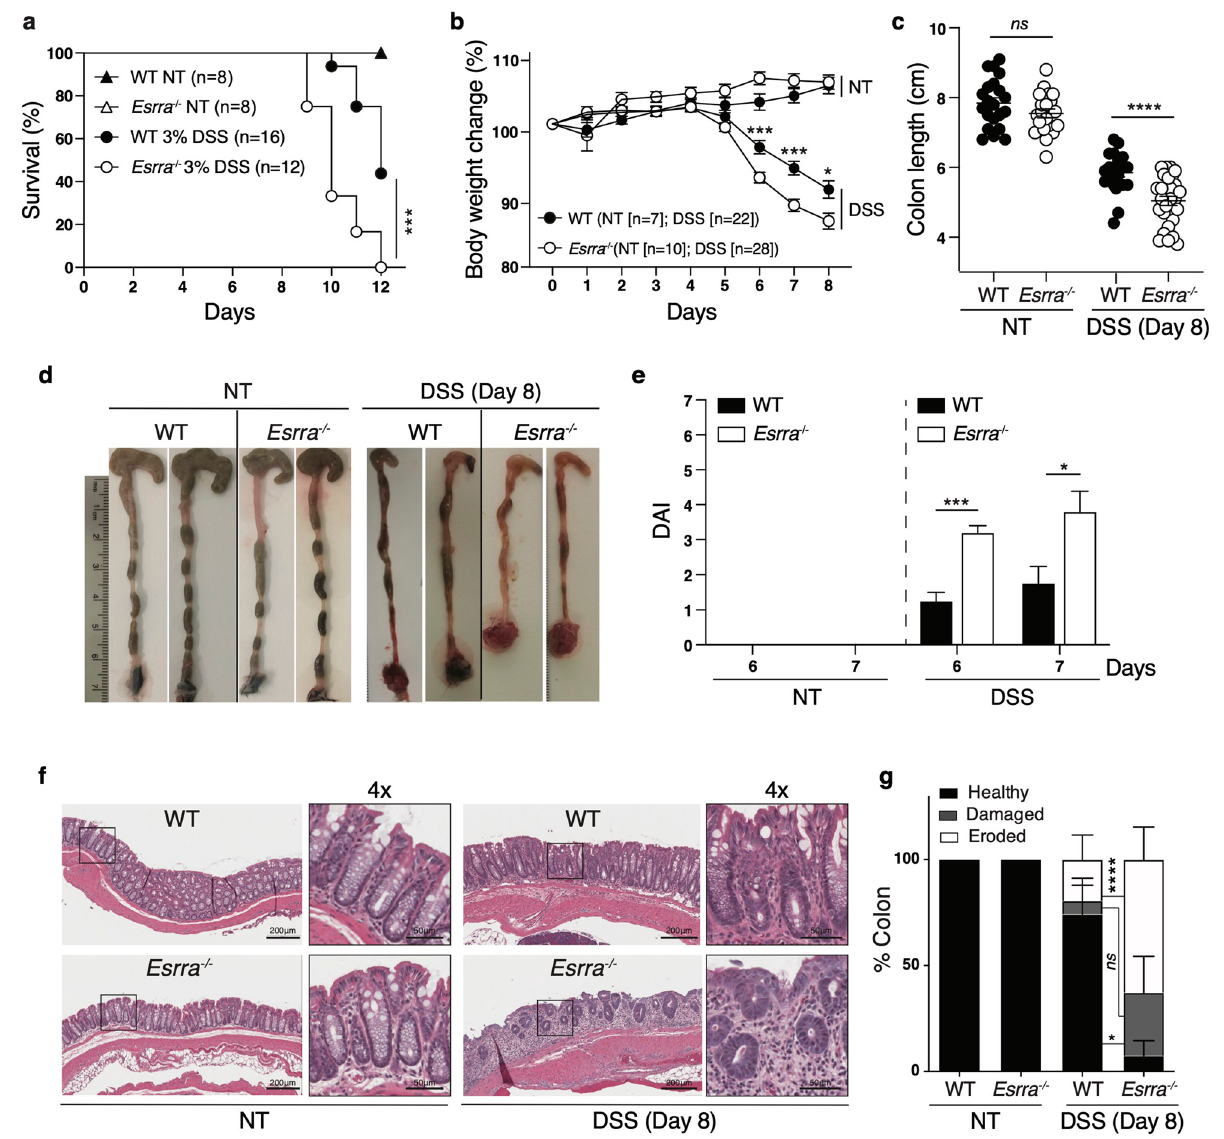
Figure 1. Esrra −/− mice exhibited heightened susceptibility to experimental colitis. ( a ) Survival of untreated (NT) WT (n = 8) and Esrra −/− (n = 8) mice and WT (n = 16) and Esrra −/− (n = 12) mice after 3% DSS treatment. Statistical significance was performed using log-rank (Mantel-Cox) test, ***p < 0.001. ( b ) Body weight loss (%) of untreated (NT) WT (n = 7) and Esrra −/− (n = 10) mice and WT (n = 22) and Esrra −/− (n = 28) mice after 3% DSS treatment. Statistical significance was performed using Student’s t-test, *p < 0.05, ***p < 0.001. ( c ) Colon lengths of untreated (NT) WT (n = 21) and Esrra −/− (n = 21) mice and WT (n = 21) and Esrra −/− (n = 28) mice after 3% DSS treatment. Each symbol represents 1 mouse; the horizontal line represents the mean + /- SEM. Statistical significance was performed using Student’s t-test, ****p < 0.0001. ns, not significant. ( d ) Representative photographs of colon and cecum from untreated (NT) WT and Esrra −/− mice or mice on day 8 after 3% DSS treatment. ( e ) Disease activity index (DAI) of untreated (NT) WT (n = 7) and Esrra −/− (n = 10) mice and 3% DSS-treated WT (n = 4) and Esrra −/− (n = 5) mice after 6 and 7 days of water or 3% DSS treatment. Statistical significance was performed using Student’s t-test, *p < 0.05, ***p < 0.001. ( f ) Representative Hematoxylin and eosin (H&E) staining of colon sections derived from untreated (NT) WT or Esrra −/− mice or mice on day 8 following 3% DSS treatment (magnification ×100, with 4 × zoom). ( g ) Intestinal tissue damage and erosion were quantified by measuring the length of healthy, damaged, eroded sections, and each category expressed as a percentage of colon length. Data represent the mean ± SEM. Statistical analysis was performed using two-way analysis of variance (ANOVA, *p < 0.05, ****p < 0.0001). ns, not